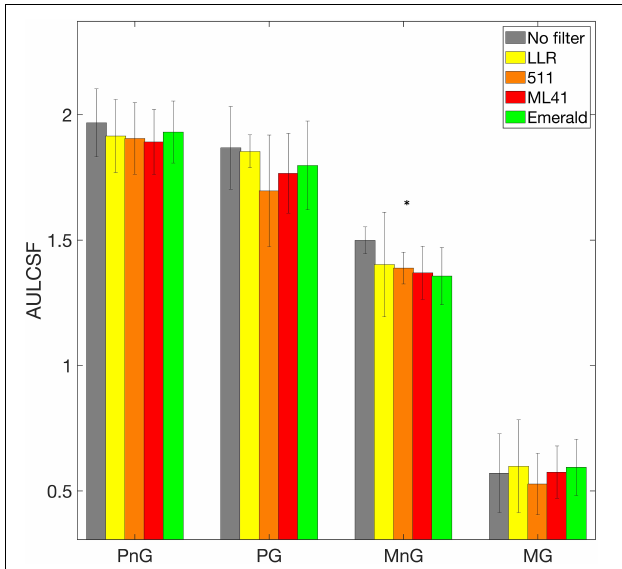
FIGURE 4 | Area under the log Contrast sensitivity function (AULCSF) values for photopic and mesopic settings with no glare and glare condition. See Figure 2 legend for the abbreviations. MnG condition showed a significant difference in the AULCSF values with different filters (marked with ∗ ). 511, ML41 and emerald filters reduced the AULCSF values compared to no filter